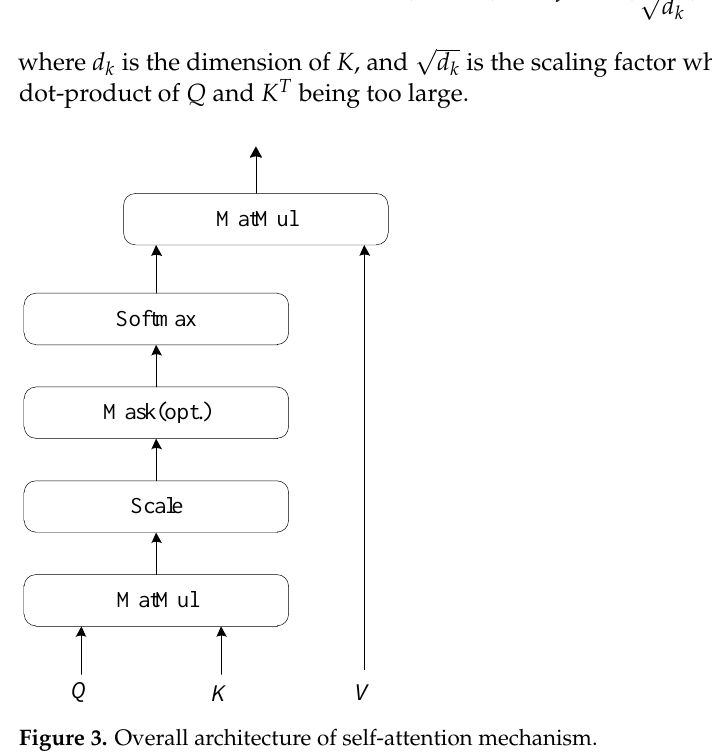
Figure 3. Overall architecture of self-attention